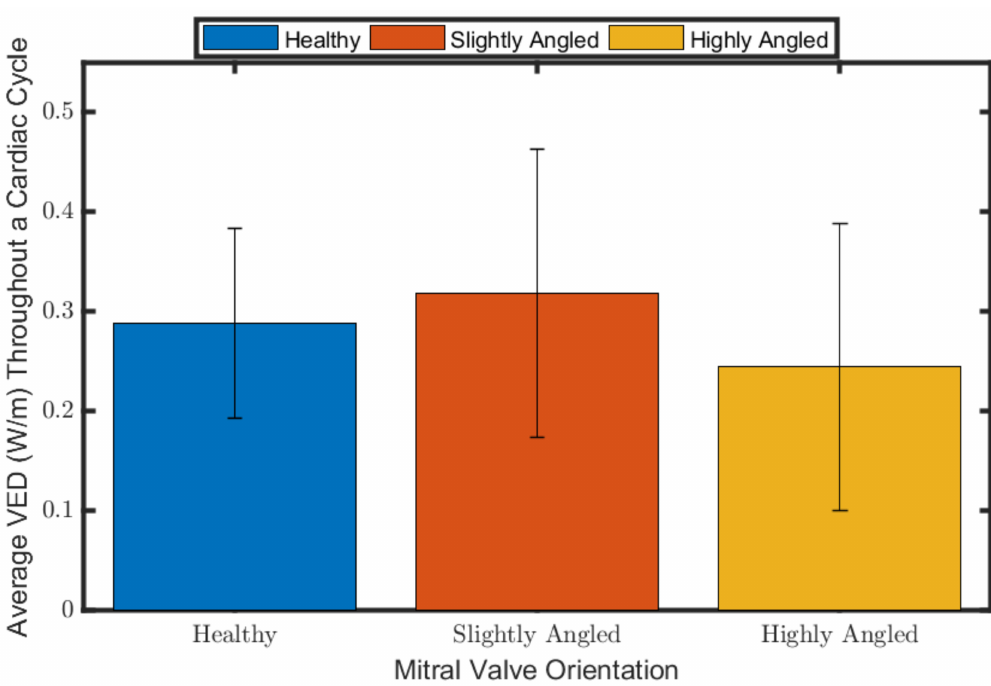
Figure 9. Average viscous energy dissipation (W/m) throughout a cardiac cycle, systole, and diastole. The p -values between the healthy case and slightly angled case, between the healthy case and highly angled case, and between the slightly angled and highly angled case are p < 0.01, p < 0.01, and p < 0.01,